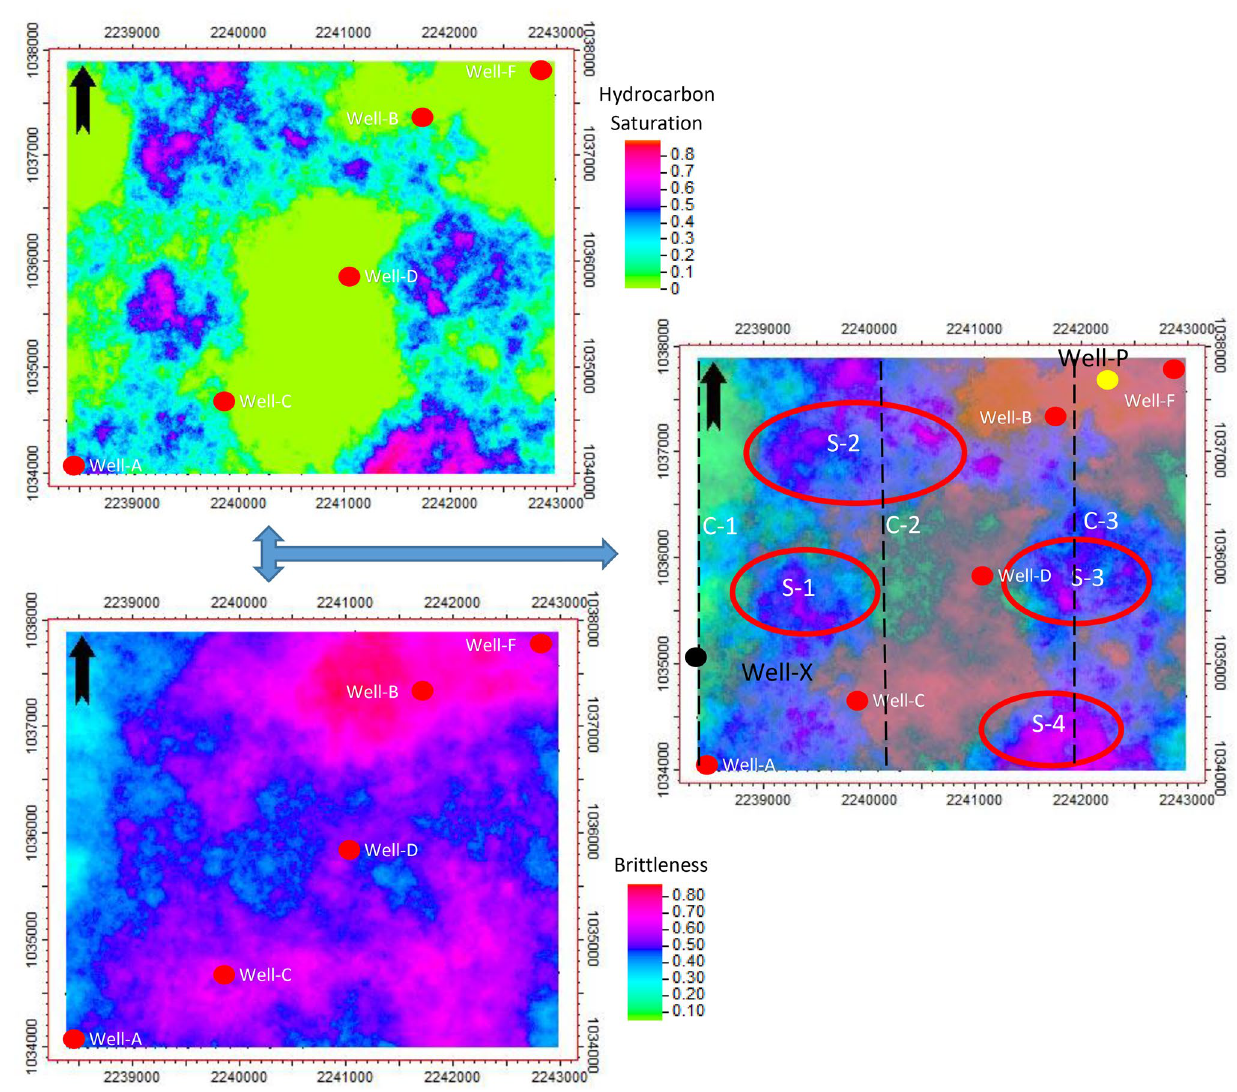
Fig. 21 Color transformation overlay analysis for sweet spot identifi- cation; the dominant colors in the color coding of the 3D model of brittleness and hydrocarbon saturation were pink, blue, purple, and Fig. 22 Cross-sectional analysis of color transformation overlay